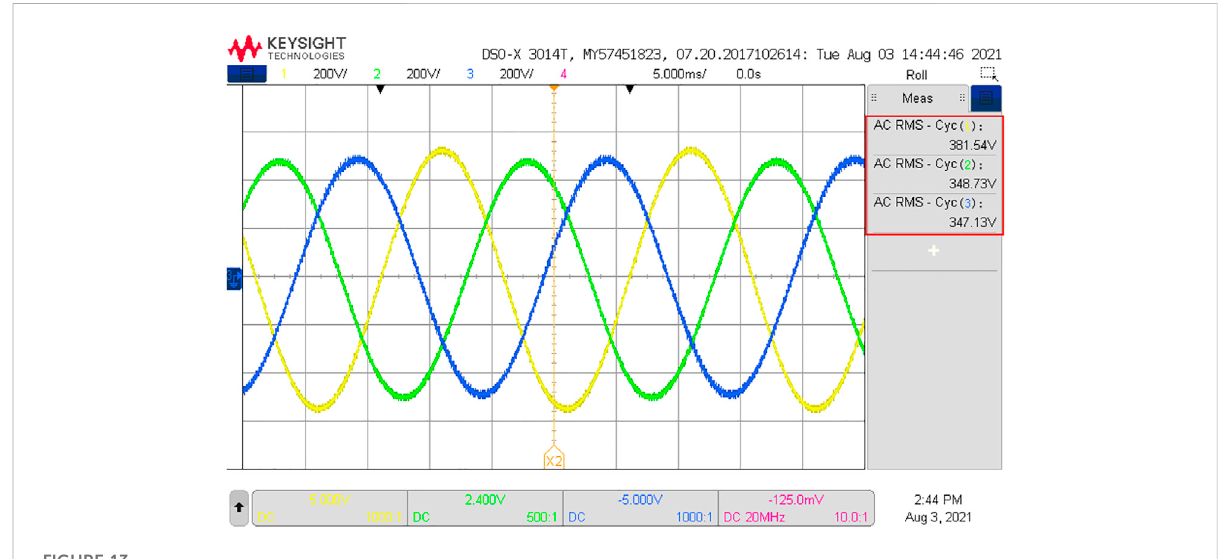
FIGURE 13 AC input voltage waveform under unbalanced grid